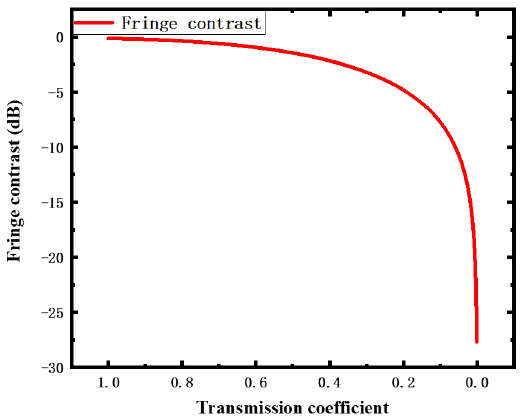
Figure 2. Relationship between transmission coefficient and fringe contrast of interference pattern.